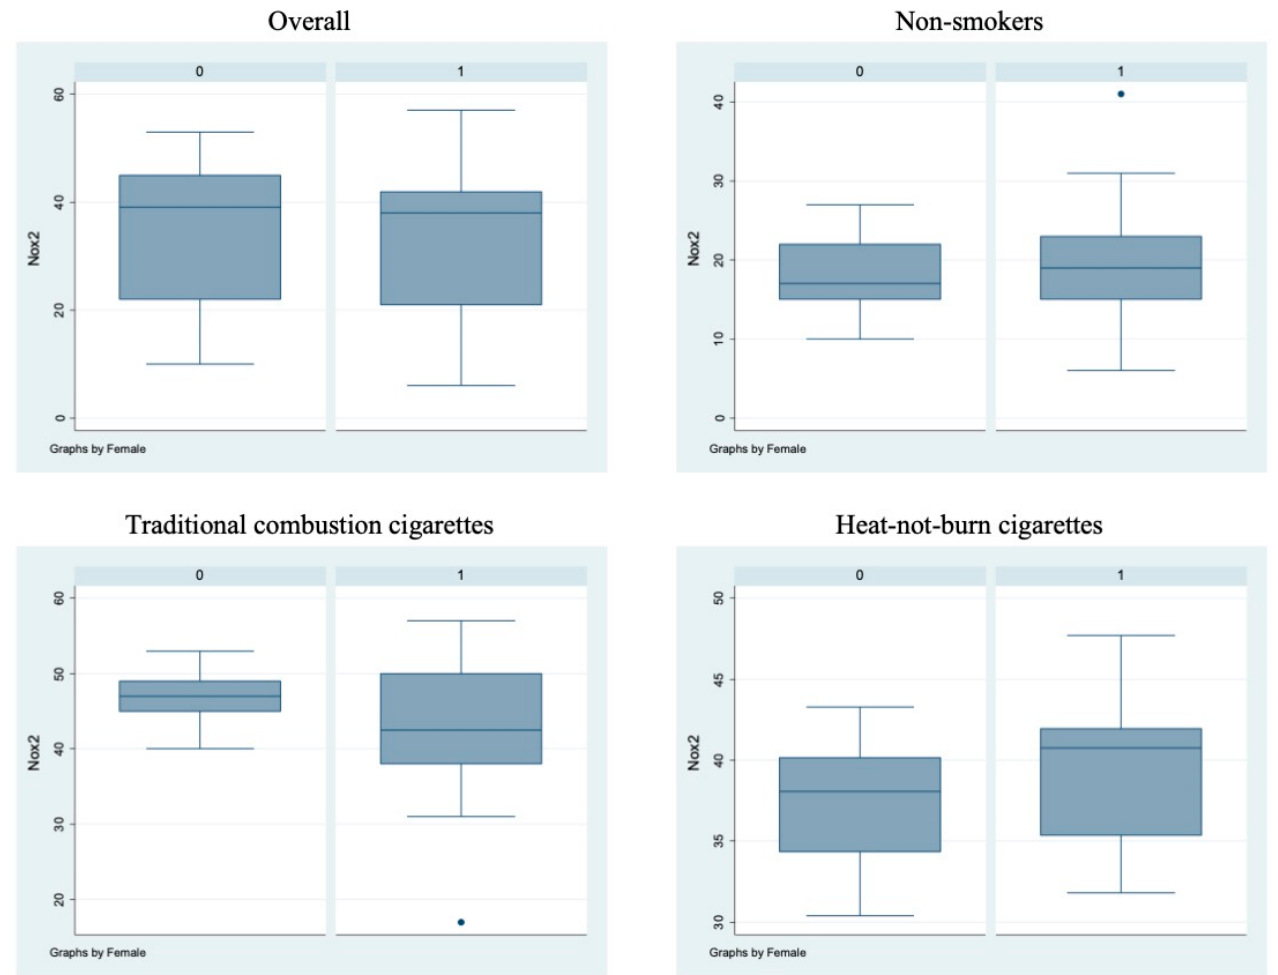
Figure 2. sNox2-dp circulating levels in the different sub-populations. Box-and-whisker plots representing sNox2-dp circulating levels (ng/mL) in the overall cohort and in non-smokers, TCCs- smokers and HNBCs-smokers subgroups. 0 = males; 1 = females; • = outlier sample